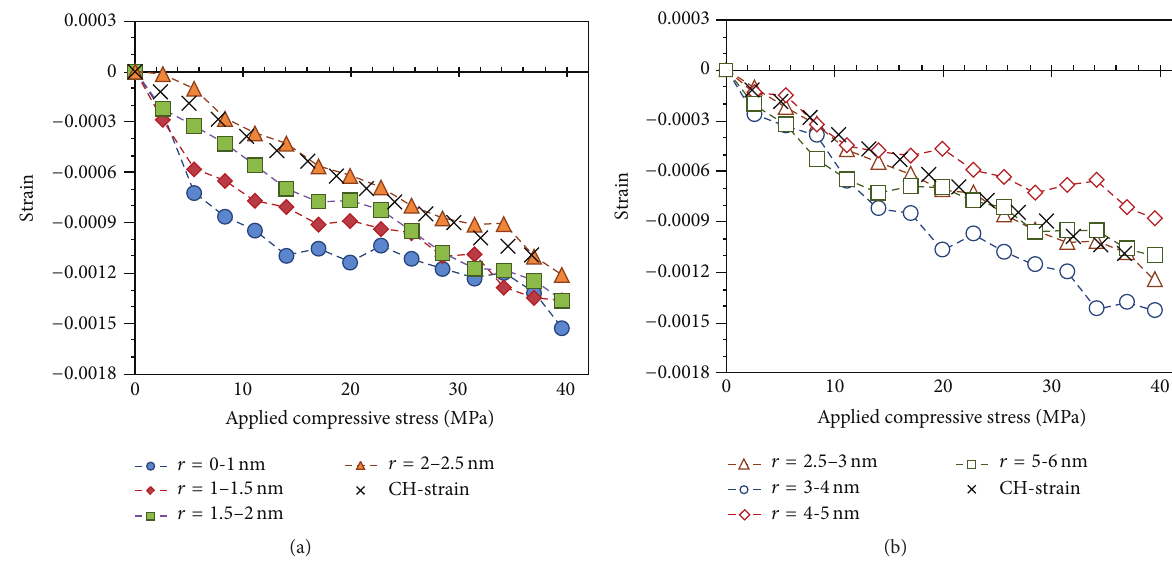
Figure 3: The atomic strains that averaged at intervals of 0.5 nm or 1.0 nm in 𝑟 , compared with the strain of the CH phase derived from the Bragg peak shift. The average error bars are ±22 × 10 −5 ( 𝑟 = 0-1nm), ±9.5 × 10 −5 ( 𝑟 = 1–1.5 nm), ±6.1 × 10 −5 ( 𝑟 = 1.5–2 nm), ±6.3 × 10 −5 ( 𝑟 =